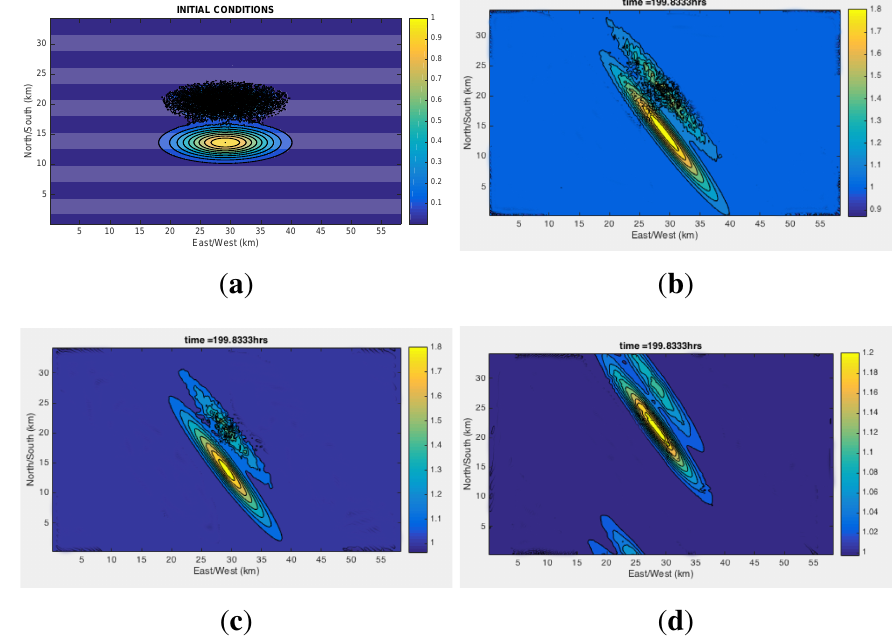
Figure 14. Effect of wave-driven diffusion/dispersion: ( a ) Initial conditions. Two Gaussians, the upper one has been multiplied by a uniformly random amplitude. Final time configurations: ( b ) Constant shear velocity applied as shown in Figure 13a, Ψ does not include waves and the advection is due to the shear only. ( c ) Shear advection and diffusion includes wave component; ( d ) Shear and waves included in the diffusion and the